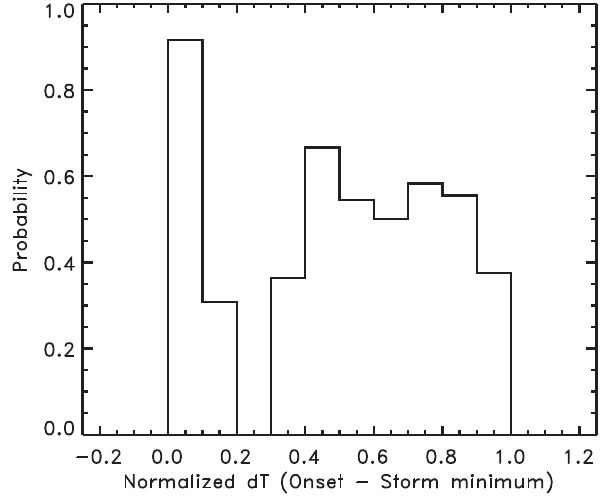
Fig. 7b. Histogram of the number of substorm onsets during main Figure 7b phase development as a function of normalized storm